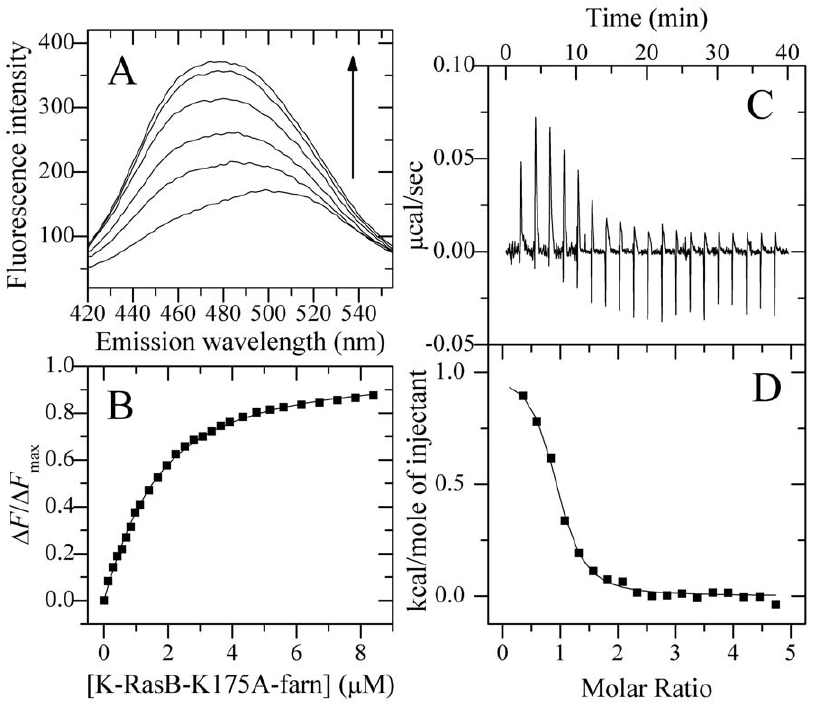
Figure 6. Interaction of farnesylated K-RasB-K175A with Ca 2 + /CaM at 25.0 6 C. Fluorescence spectra (A) of 1.0 m M dansyl-CaM in the absence and in the presence of GppNHp bound K-RasB-K175A-farn at different concentrations. The arrow represents the concentration of K-RasB-K175A-farn increases gradually from 0 (the bottom) to 8.4 m M (the top). D F / D F max for the binding of K-RasB-K175A-farn to Ca 2 + /CaM plotted as a function of the concentration of K-RasB-K175A-farn (B). The solid squares were the experimental data and the solid line represented the best fit. The panel C represents typical calorimetric titration of K-RasB-K175A-farn (25.0 m M) with CaM (600 m M) in the presence of 1 mM CaCl 2 . The panel D shows the plots of the heat evolved (kcal) per mole of CaM added, corrected for the heat of CaM, against the molar ratio of CaM to K-RasB. The data (solid squares) were fitted to a single set of identical sites model and the solid line represented the best fit. The corresponding parameters from B and D are summarized in Table 1.